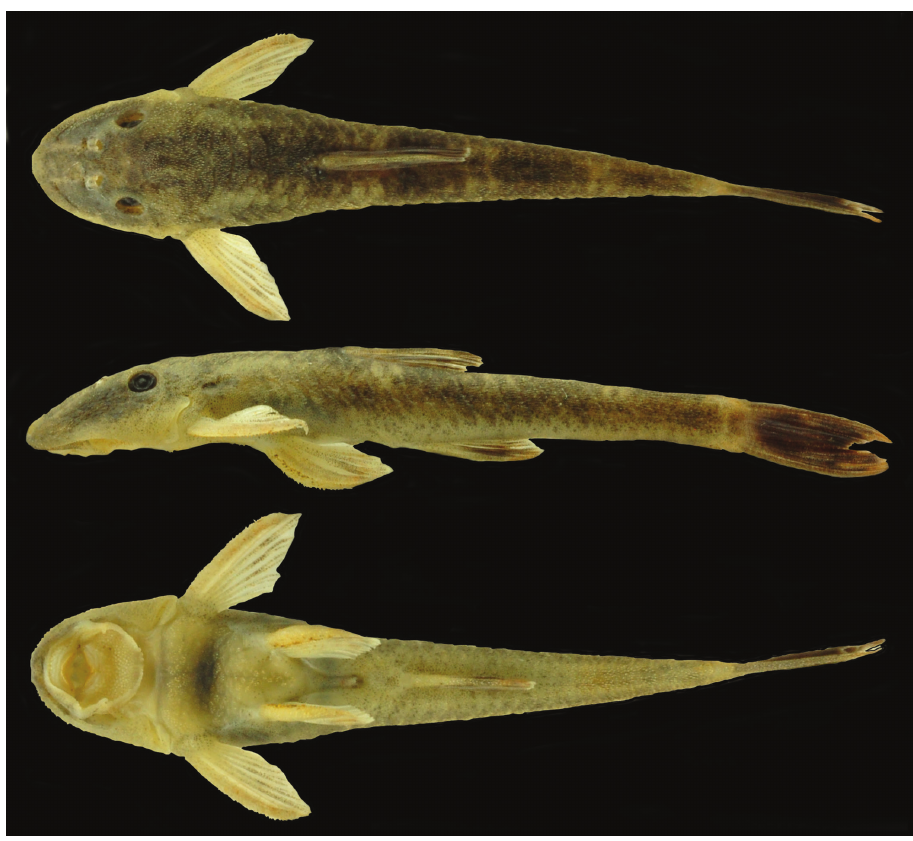
Figure 1. Rhinolekos capetinga MZUSP 116102, holotype, male, 37.5 mm SL, Goiás State, rio Tocantins basin,